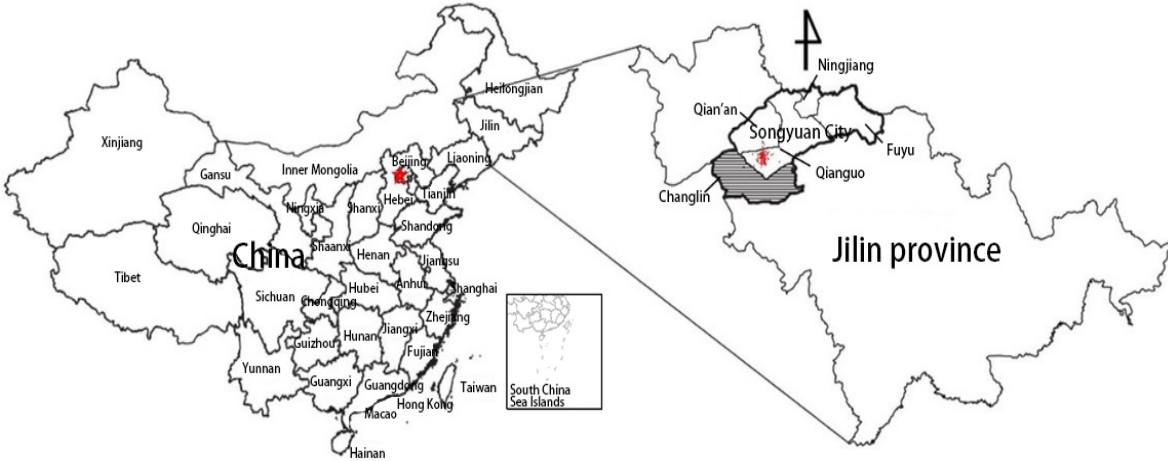
Figure 1. Location of study area. Note: The red spot in Jilin province indicates the epicenter of the earthquake swarm. The shaded part is the survey area.